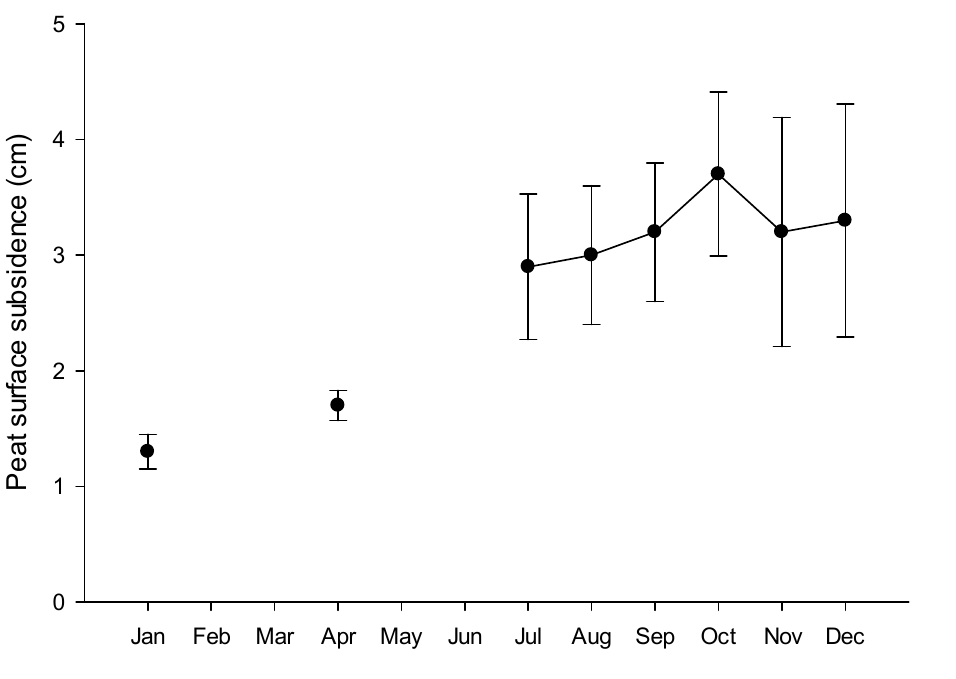
Figure 8. Mean peat surface subsidence with error bars measured using five subsidence poles at the 1 ha